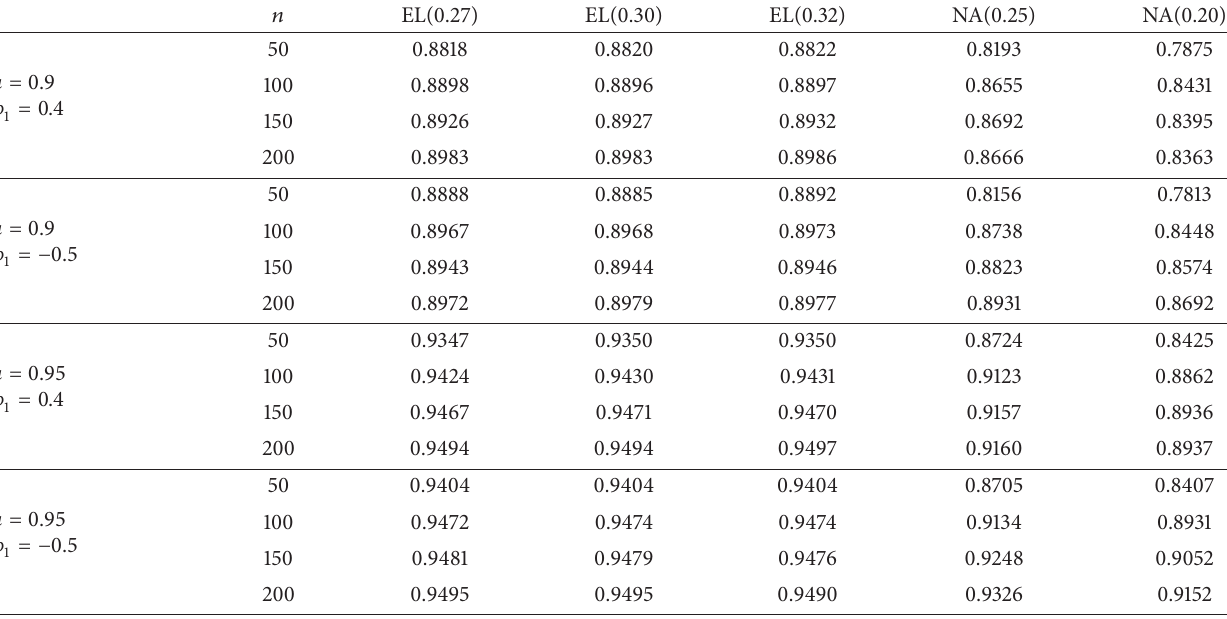
Table 1: The coverage probability of confidence intervals when 𝜀 𝑡 ∼ 𝑁(0,1)